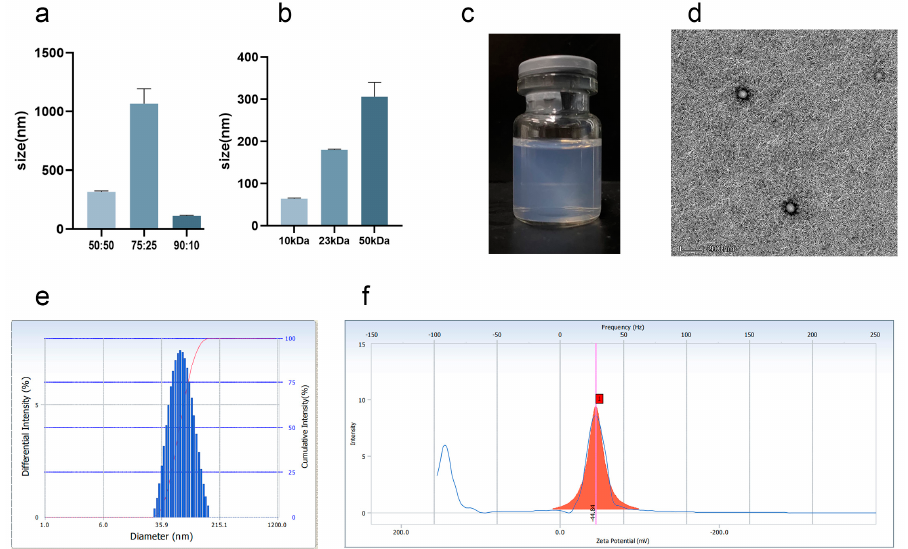
Figure 2. The preparation of Cel-NPs. ( a ) When the molecular weight of PLGA was 1 w, the particle size of Cel-NPs was 90% under the copolymerization ratio of 50:50, 75:25, and 90:10; ( b ) The average particle size of Cel-NPs with molecular weights of 10, 23, and 50 kDa at a PLGA copolymerization ratio of 90:10; ( c ) Cel-NPs external view; ( d ) Cel-NPs under a transmission electron microscope (scale: 200 nm); ( e ) The particle size distribution of Cel-NPs was prepared using PLGA with a molecular weight of 10 kDa and a copolymerization ratio of 90:10 as a carrier; ( f ) Potential distribution map (The red square on the x-axis is the potential value).